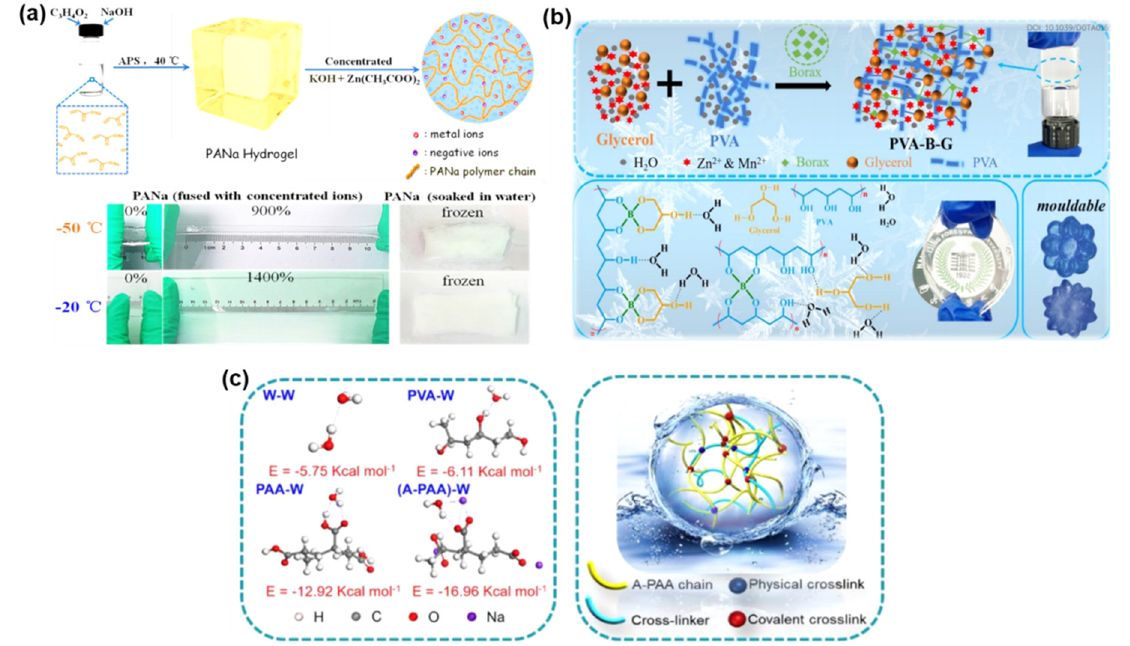
Figure 3. ( a ) The molecular structure and stretchability of the anti-freezing concentrated PANa hydrogel electrolyte. Reproduced with permission from [47]. ( b ) Schematic fabrication of PVA − B − G hydrogel. Reproduced with permission from [48]. ( c ) Molecular models and simulated interactions between terminal groups and water molecules in different hydrogels. Reproduced with permission from [49].